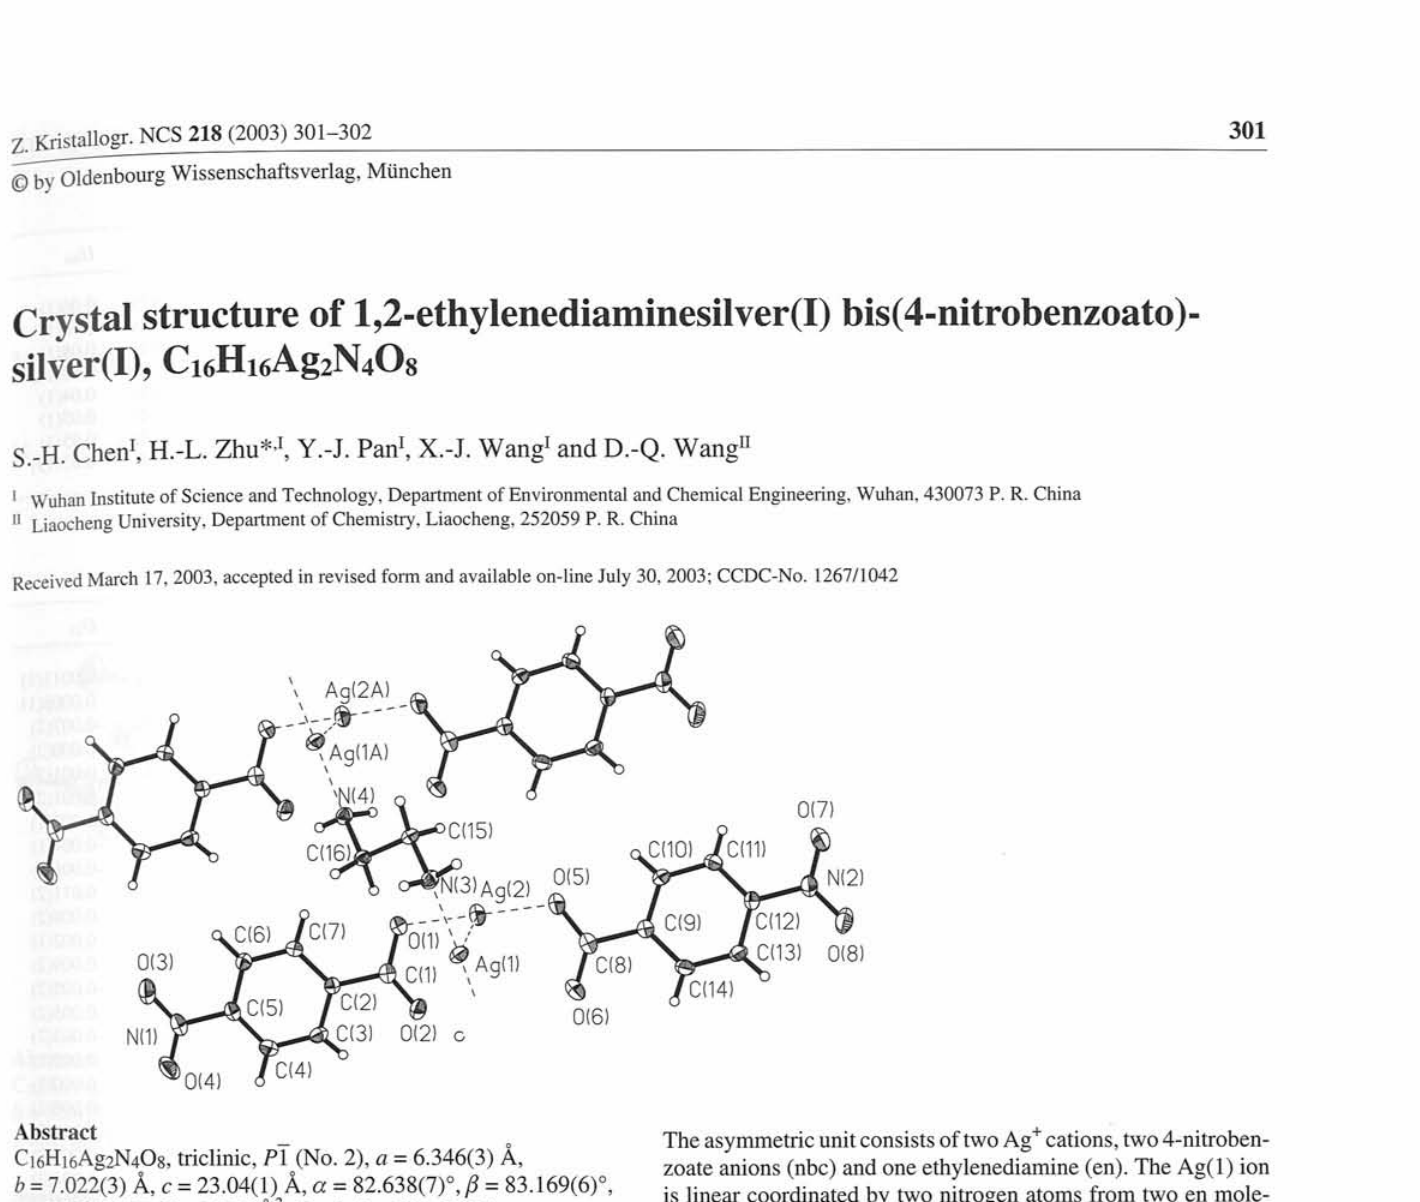
Table 1. Data collection and handling.